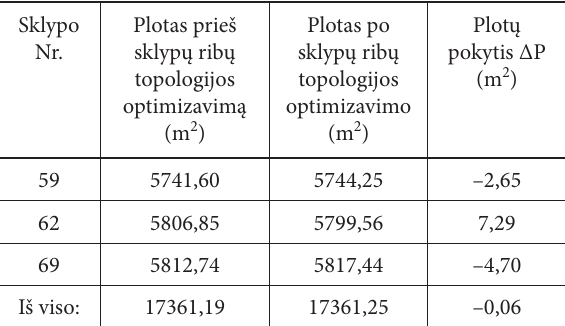
Table 8. The comparison of the land area before and after optimization Sklypo Nr.